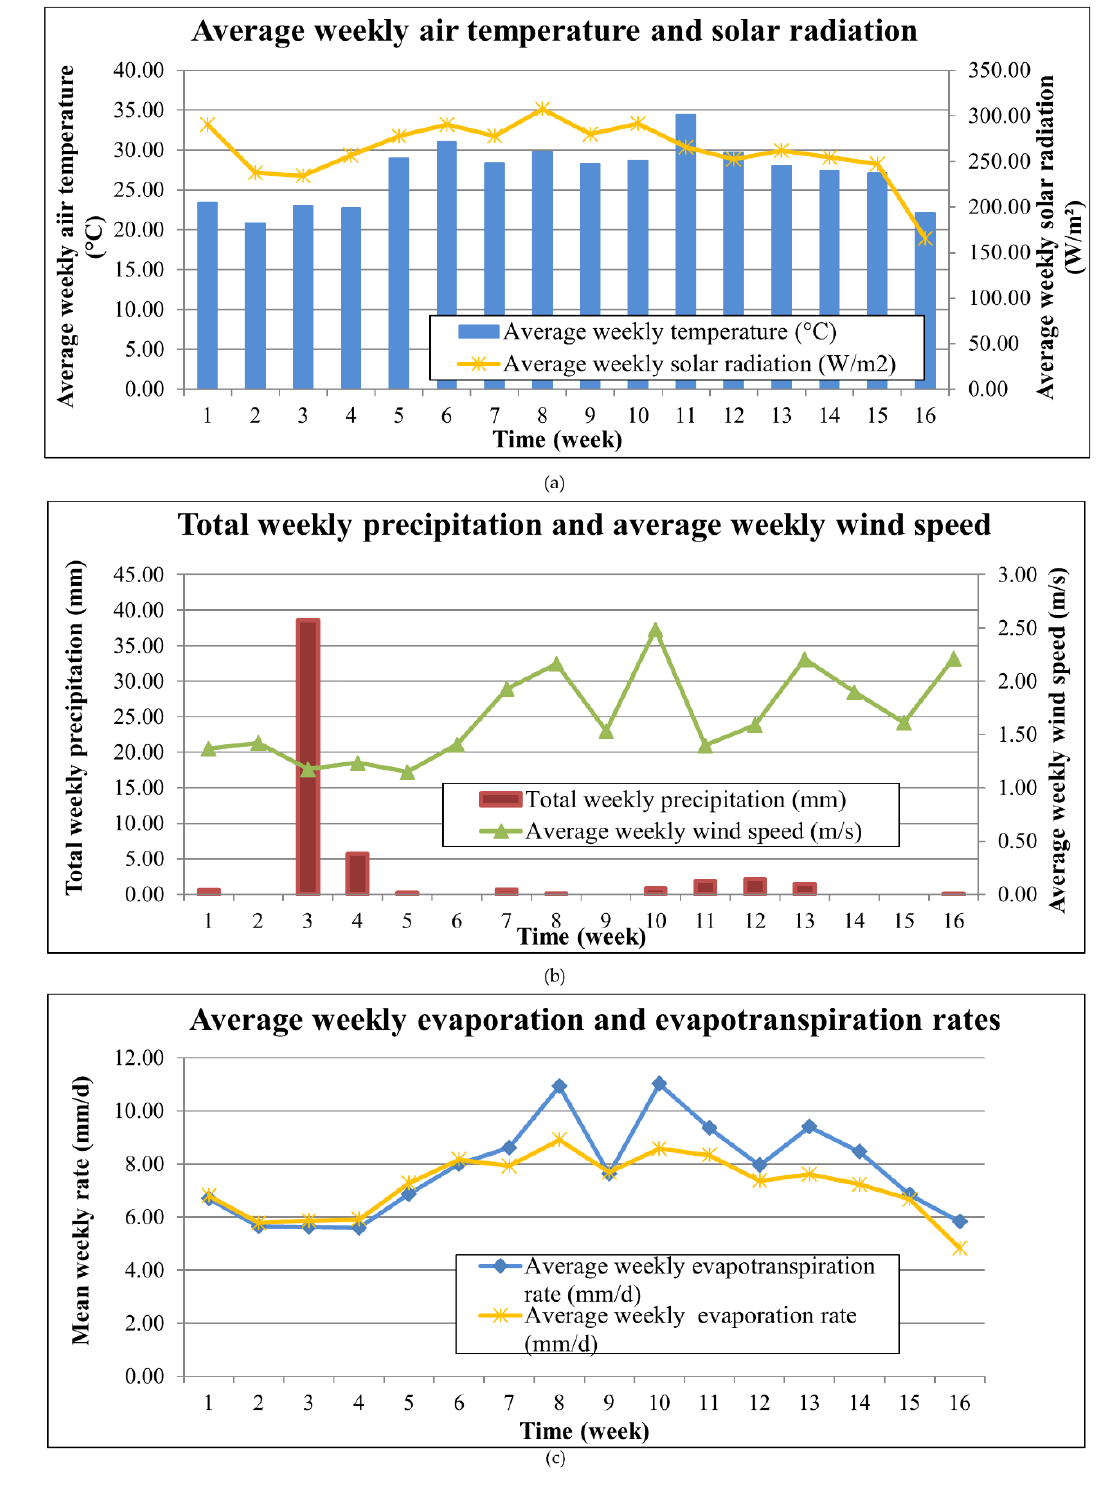
Figure 9. Temporal variation of ( a ) average weekly air temperature and solar radiation; ( b ) total weekly precipitation and average weekly wind speed; and ( c ) average weekly evaporation and evapotranspiration rates.